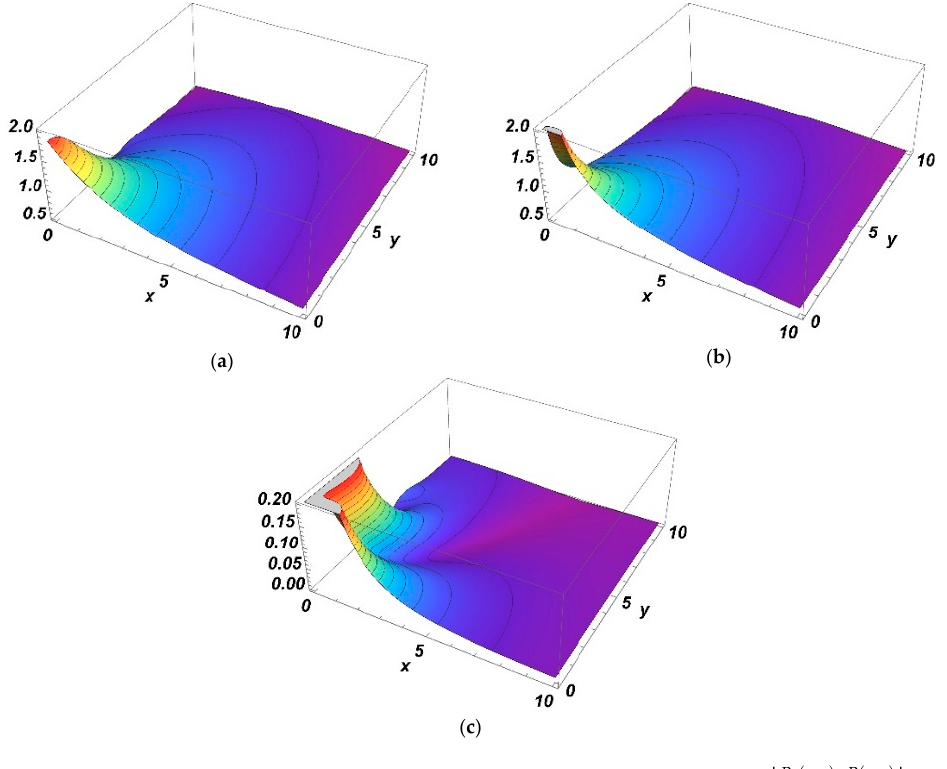
(cid:12) (cid:12) (cid:12) (cid:12) (cid:12) P ( x , y ) (cid:12) ( a ), function